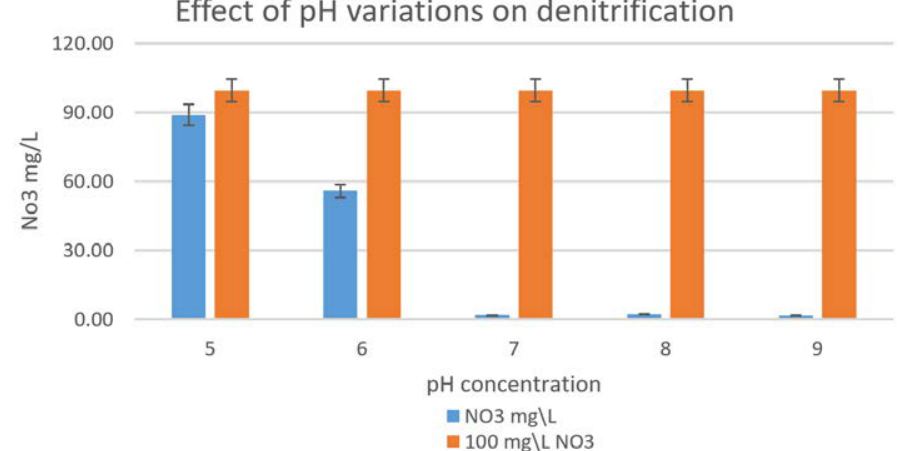
Fig. 5 . The effect of pH variations on the denitrification process is shown in the graph. At least 100mg/L nitrate was used as a fixed starting point. It was shown that pH7, 8, and 9 were optimum for denitrification processes by Pseudomonas aeruginosa on glucose